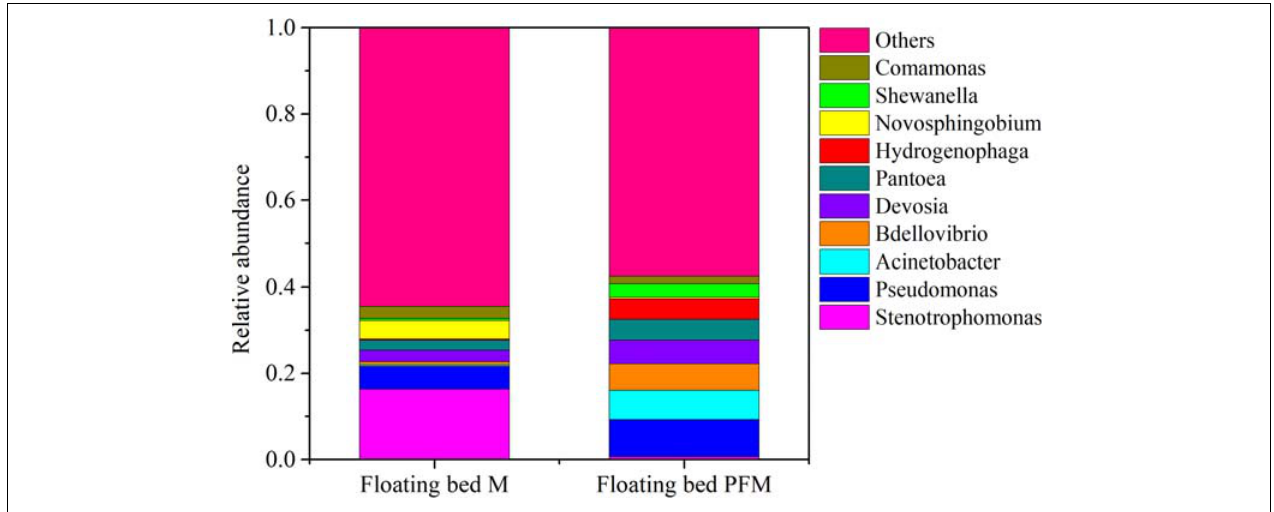
FIGURE 3 | Relative abundance of microbial community at the Genus level.